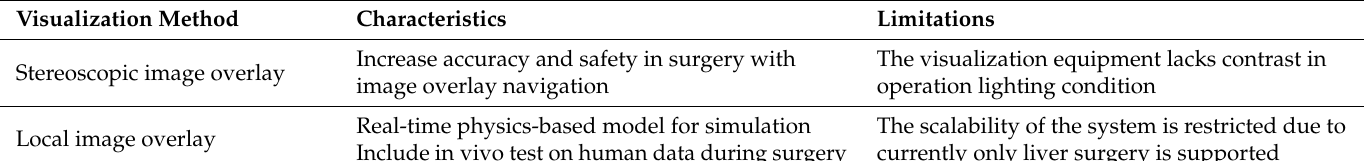
Table 2. Characteristics and limitations of research in biomedical engineering and